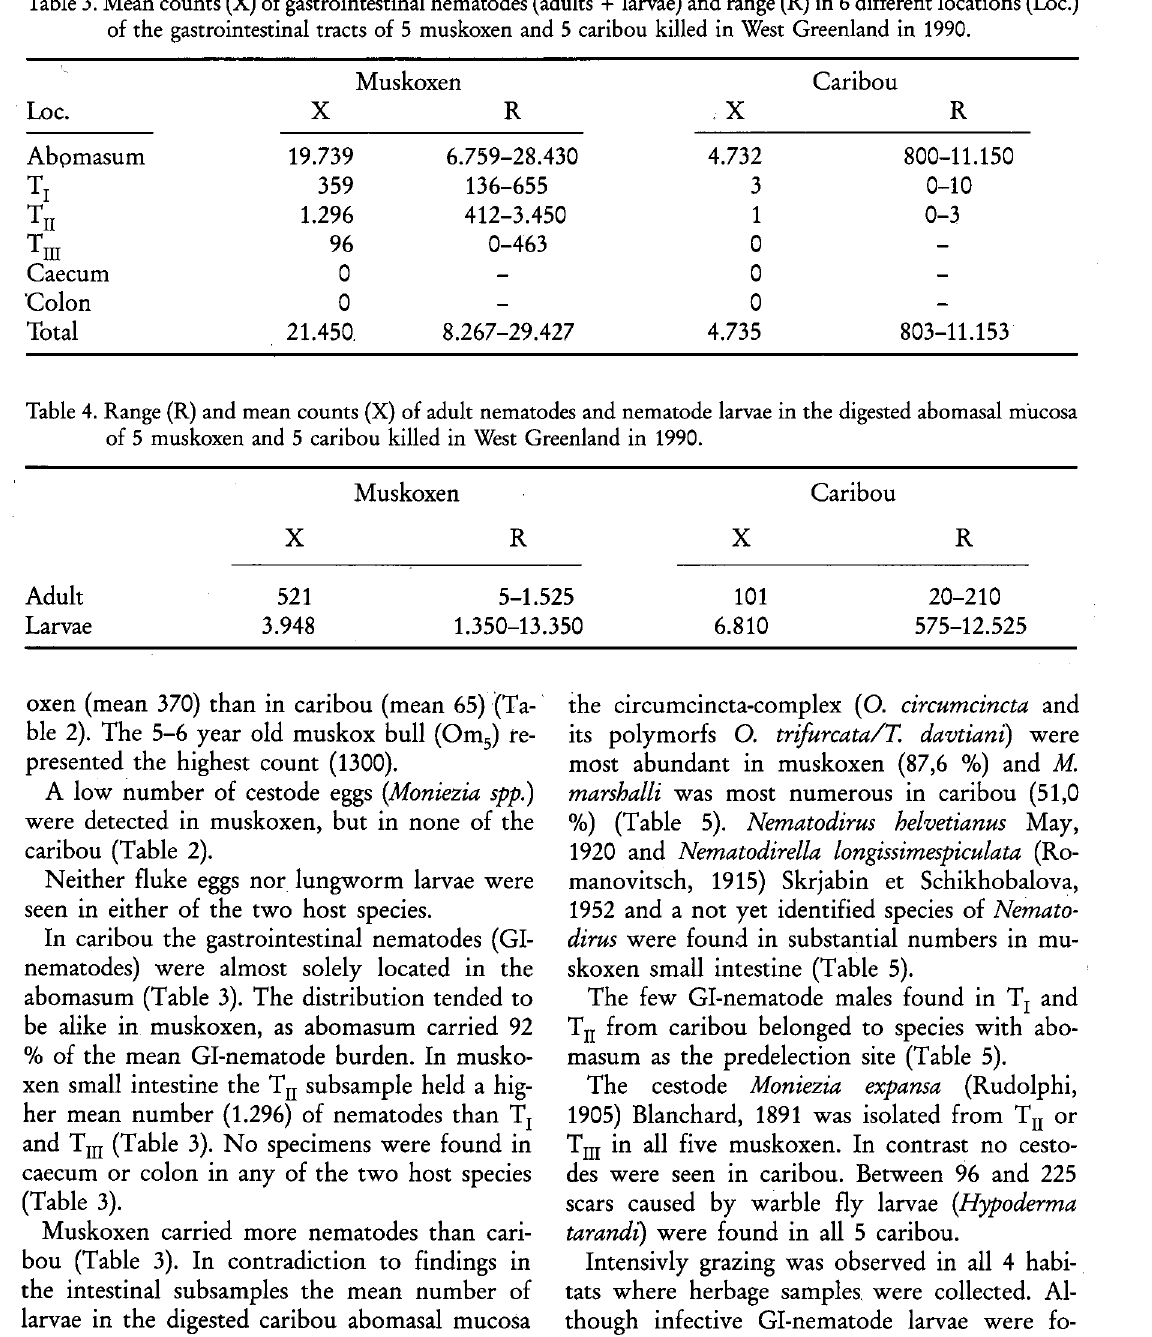
Table 3. Mean counts (X) of gastrointestinal nematodes (adults + larvae) and range (R) in 6 different locations (Loc.) of the gastrointestinal tracts of 5 muskoxen and 5 caribou killed in West Greenland in 1990. Muskoxen Loc.